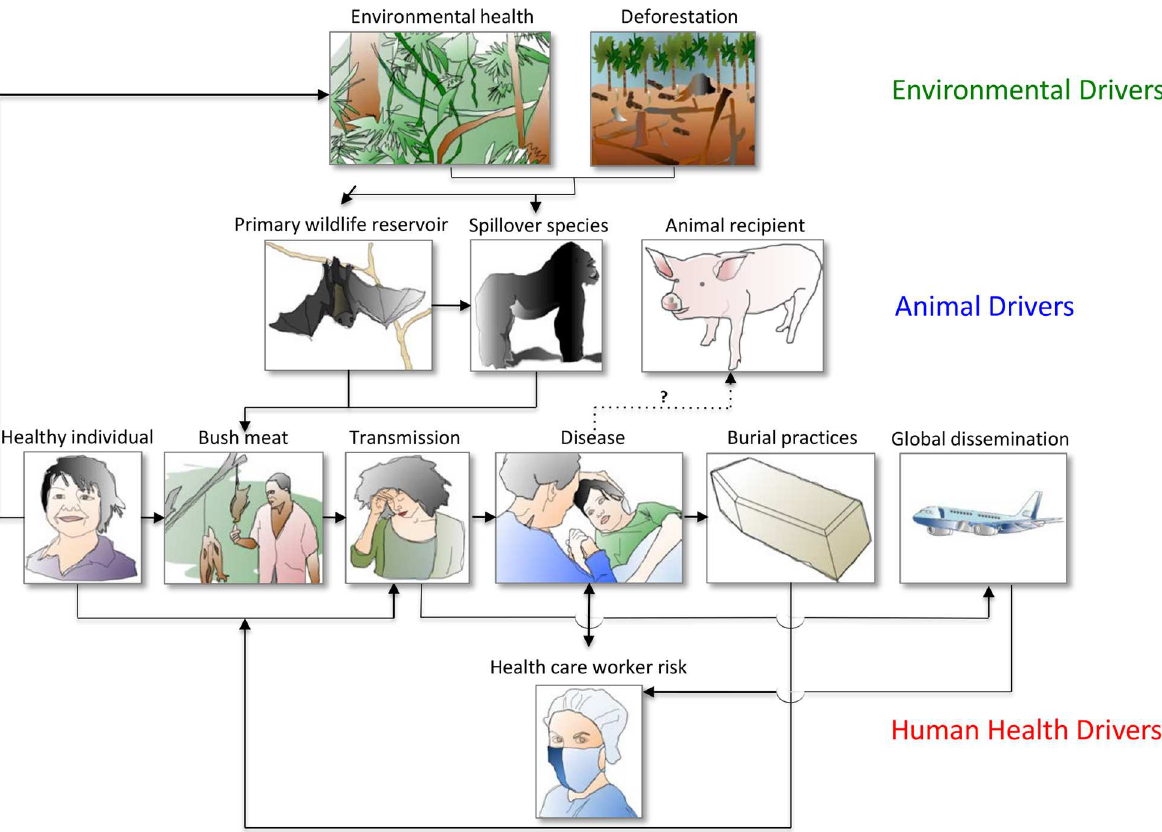
Fig 2. Ebola as a case study of interactionsbetweenhuman,animal,and environmentalhealthdrivers. Climacticand anthropomorphicfactors influence environmental drivers such as drought and deforestation. These factors in turnaffect the populations and migrationsof the primaryreservoirof the Ebola virus, fruitbats, as well as otheranimalsthat may prey upon them or competewith them for fruit.These animaldriversinfluencethe routesand rates of humaninfection throughbushmeat consumptionand possibly other means. Human-to-humanspread is exacerbated by burial practices, caregiver barrierprotocols,and global travel. Humandrivers of disease feed back to influenceanimalhealth via possible pet infection and the transportof infected wildlife, and environmental health throughincreasing human–animal contacts throughharvesting naturalresourcesfromremoteforests.